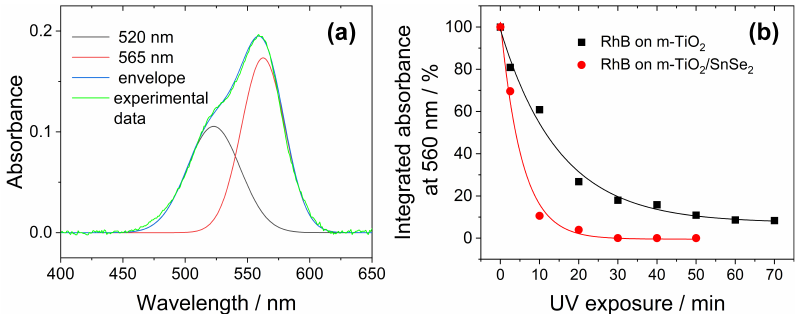
Figure 10. ( a ) Optical absorption spectrum of RhB deposited on m-TiO 2 film and curve fit with 2 Gaussian functions. ( b ) Decrease of the integrated absorbance calculated from the Gaussian function peaked at 565 from the spectra of RhB deposited on m-TiO 2 and m-TiO 2 -SnSe 2 films (black squares and red dots, respectively). The lines depict the exponential decay fit of the experimental data.